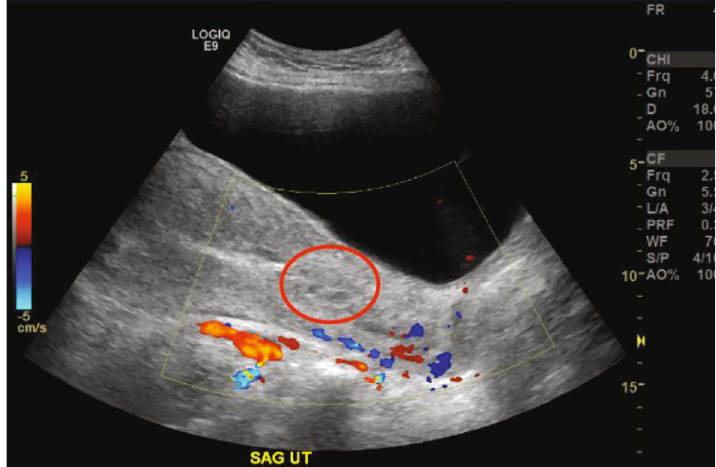
Figure 3: Transvaginal ultrasound of the uterus. Sagittal view of the uterus demonstrated complex echogenic area in the lower uterine segment without Doppler fl ow, consistent with a blood clot (encircled in red) measuring approximately 2.9cm in